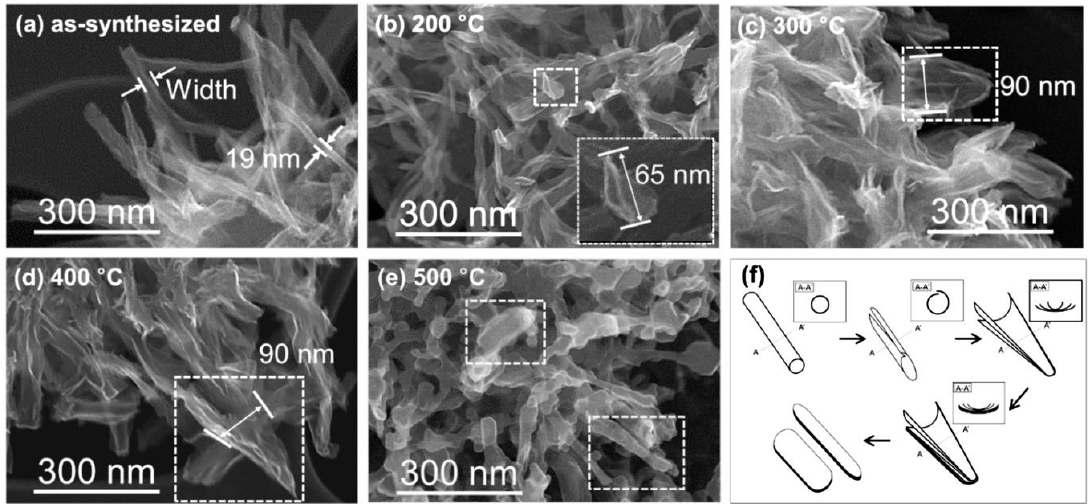
Figure 2. Scanning electron microscopy (SEM) images of ( a ) as-synthesized PTNTs and ( b – e ) annealed PTNTs at 200, 300, 400 and 500 °C for 1 h, respectively. ( f ) Schematic description of the annealing temperature effect on the morphologies of PTNTs.